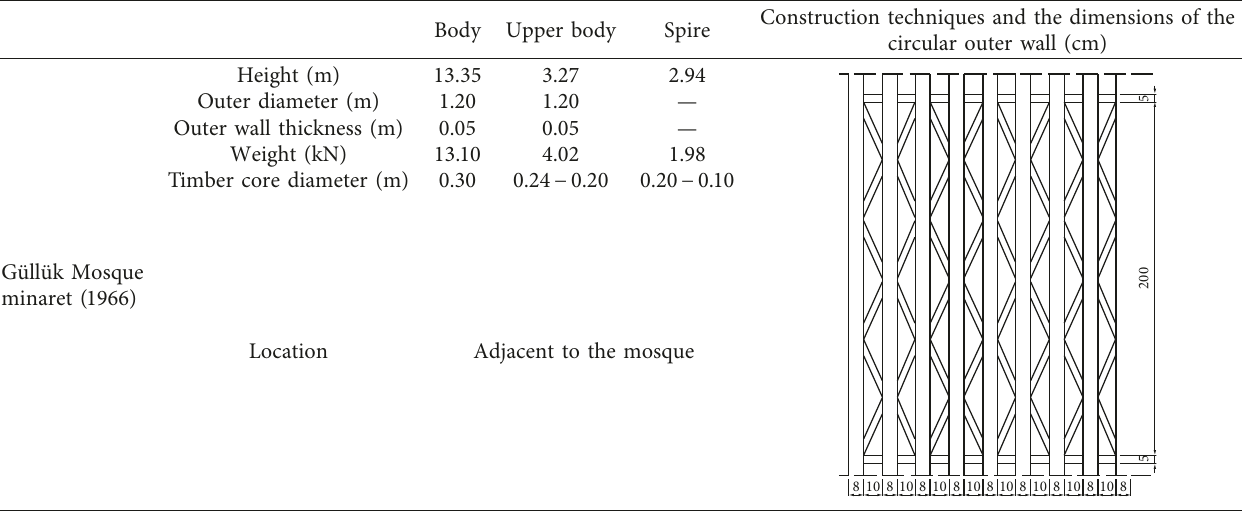
Table 2: The geometric properties and construction techniques of the G¨ull¨uk Mosque minaret. Construction techniques and the dimensions of the Body Upper body Spire circular outer wall (cm)